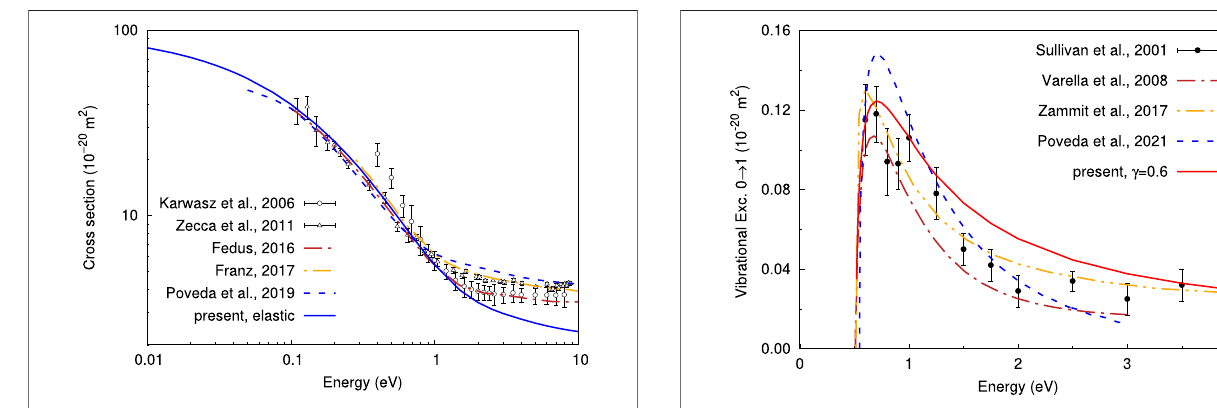
FIGURE 6 | (Color online) Elastic (present result and [16]) and total cross sections for positron scattering from N 2 . The present result correspond to a model potential with κ =0.5, ρ =2.05 and γ =1.